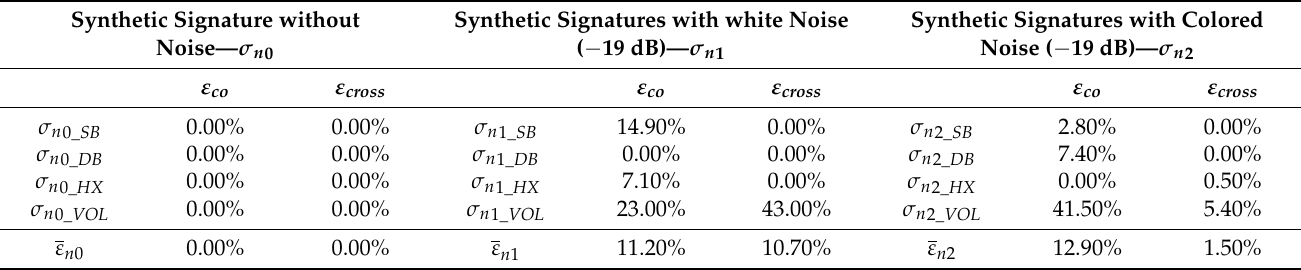
Table 2. Inaccuracies for SA-based decomposition method revealed for synthetic-signature recogni- tion. Recognized signatures are specified in